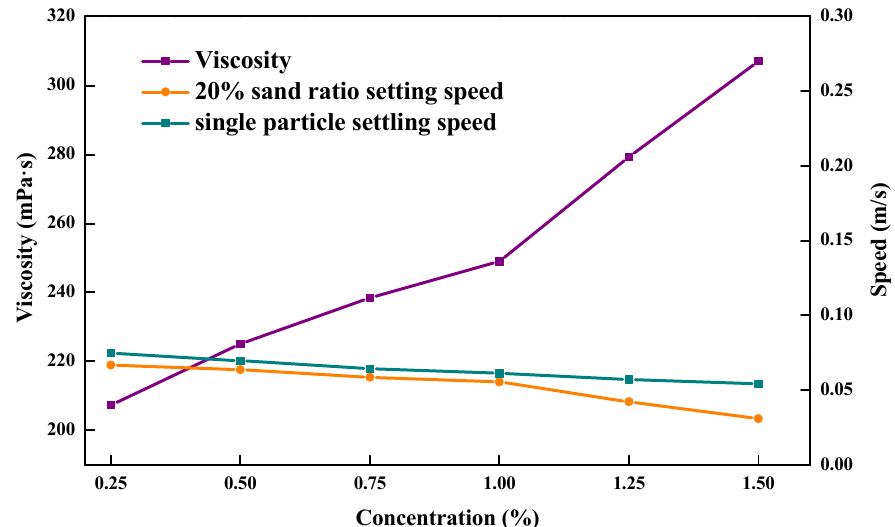
Figure 12. Relationships between the ZJL-1 fracturing fluid concentration and sedimentation rate and viscosity.